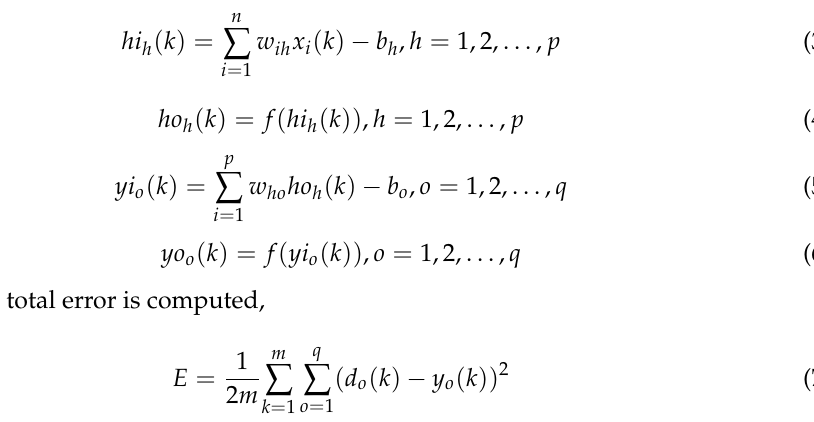
Figure 1. The architecture of the FFANN-BP. The k -th input sample x ( k ) = ( x 1 ( k ) , x 2 ( k ) , . . . , x n ( k )) is randomly selected, and the corresponding expected output are d o ( k ) = ( d 1 ( k ) , d 2 ( k ) , . . . , d q ( k )) and calculate the